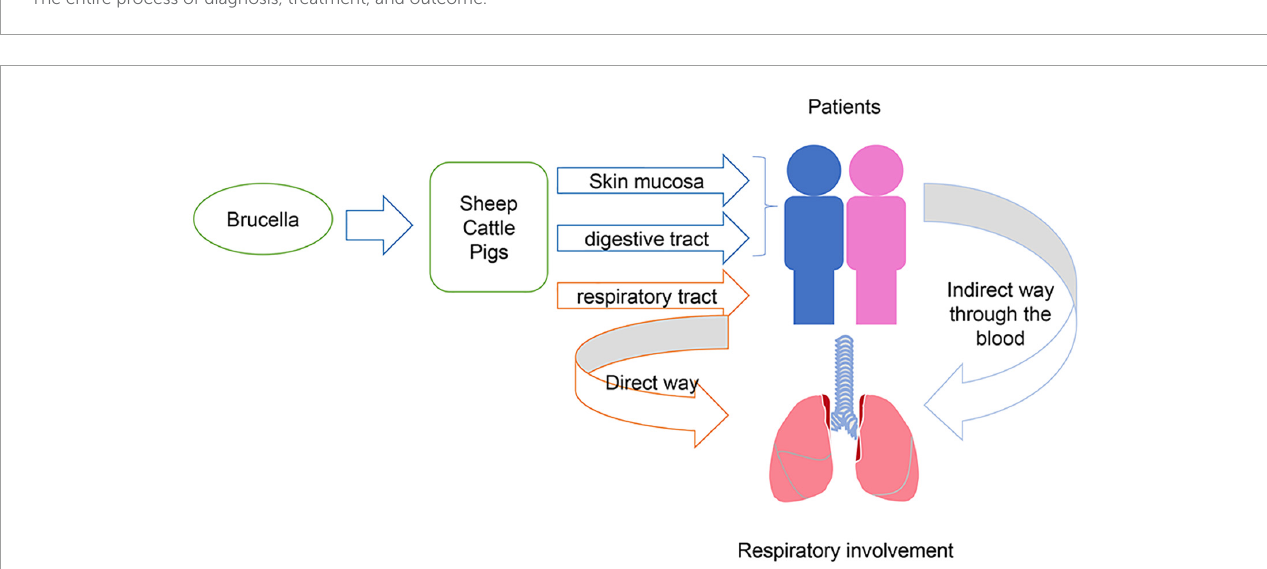
FIGURE3 Mechanism of respiratory involvement by Brucella